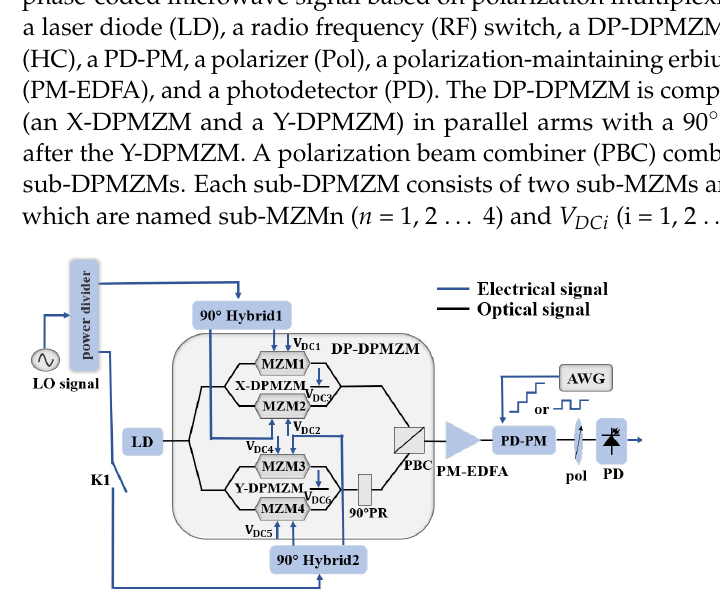
Figure 1. Schematic diagram of the proposed scheme. LD: laser diode; DP-DPMZM: dual-parallel dual-polarization Mach–Zehnder modulator; PR: polarization rotator; PBC: polarization beam com- biner; PD-PM: polarization-dependent phase modulator; Pol: polarizer; PM-EDFA: polarization- maintaining erbium-doped fiber amplifier; PD: photodetector; LO: local oscillator signal; K1: radio frequency